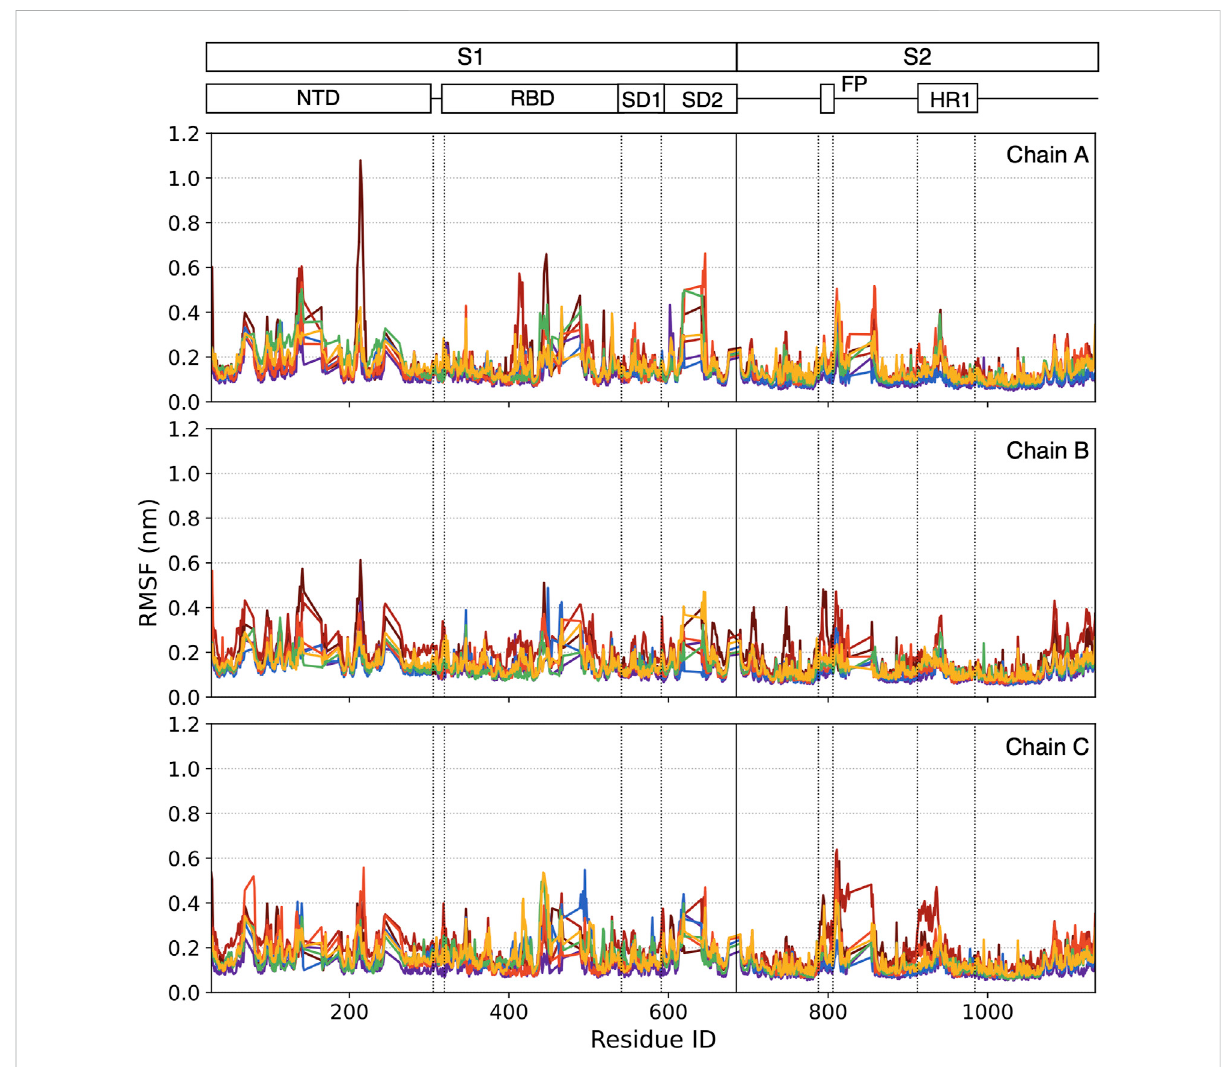
FIGURE 8 RMSF for each residue on three chains within the last 0.5 μ s